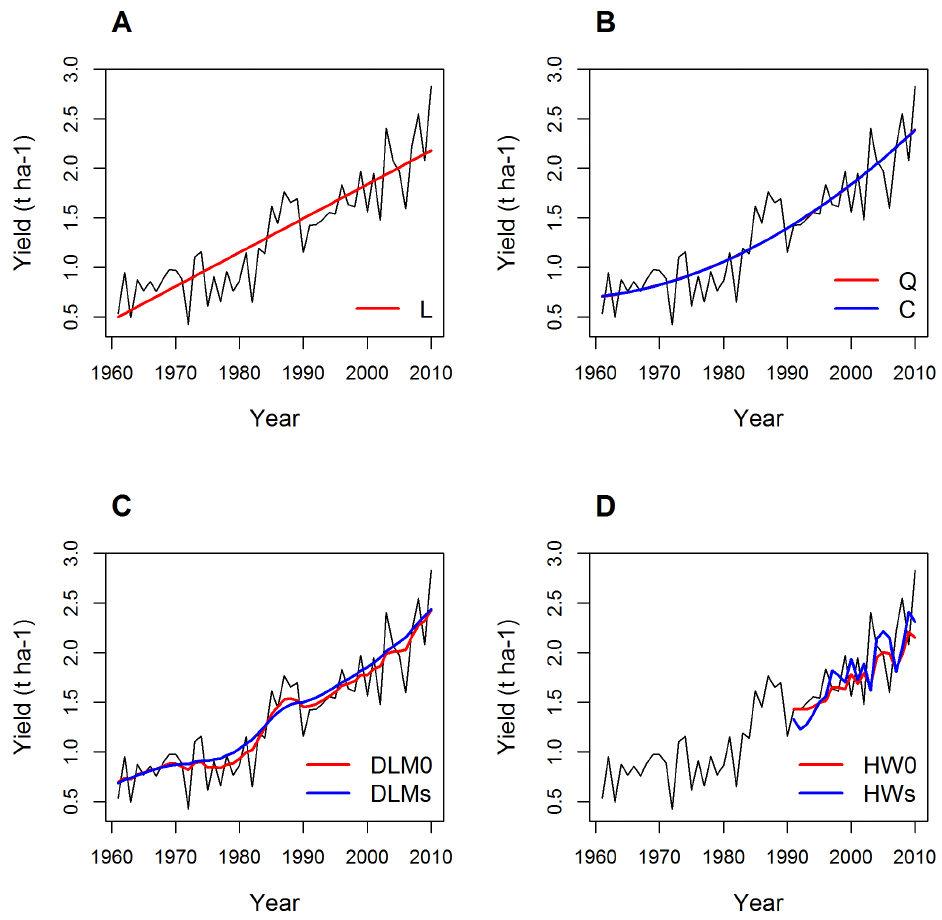
Figure 2. Wheat yield time series in Brazil and fitted values obtained with different models. A: linear (L) and linear-plus-plateau (LP) models. B: Quadratic (Q) and cubic (C) models. C: dynamic linear models with and without trend (DLMs, DLM0). D: Holt-Winters model with and without trend (HWs, HW0).